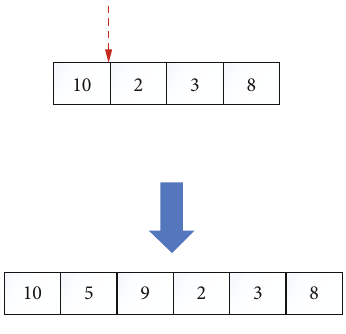
Figure 3: Random insertion of two